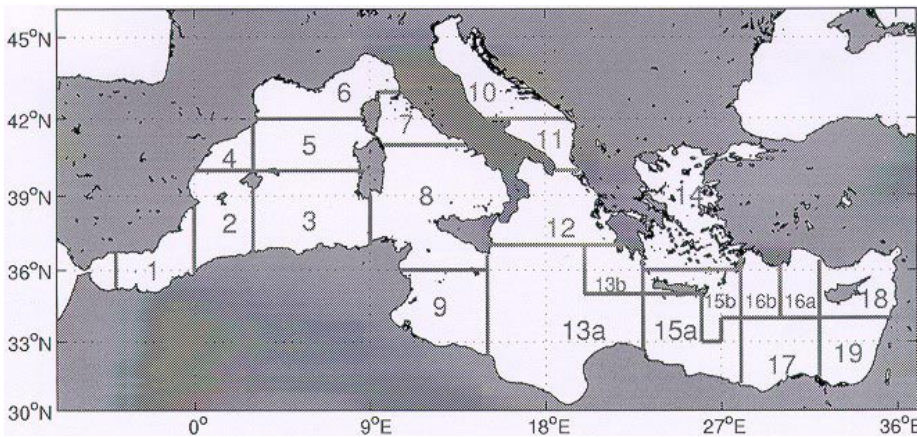
Fig. 4. The homogeneous areas derived from comparison of mean profiles and standard deviations.